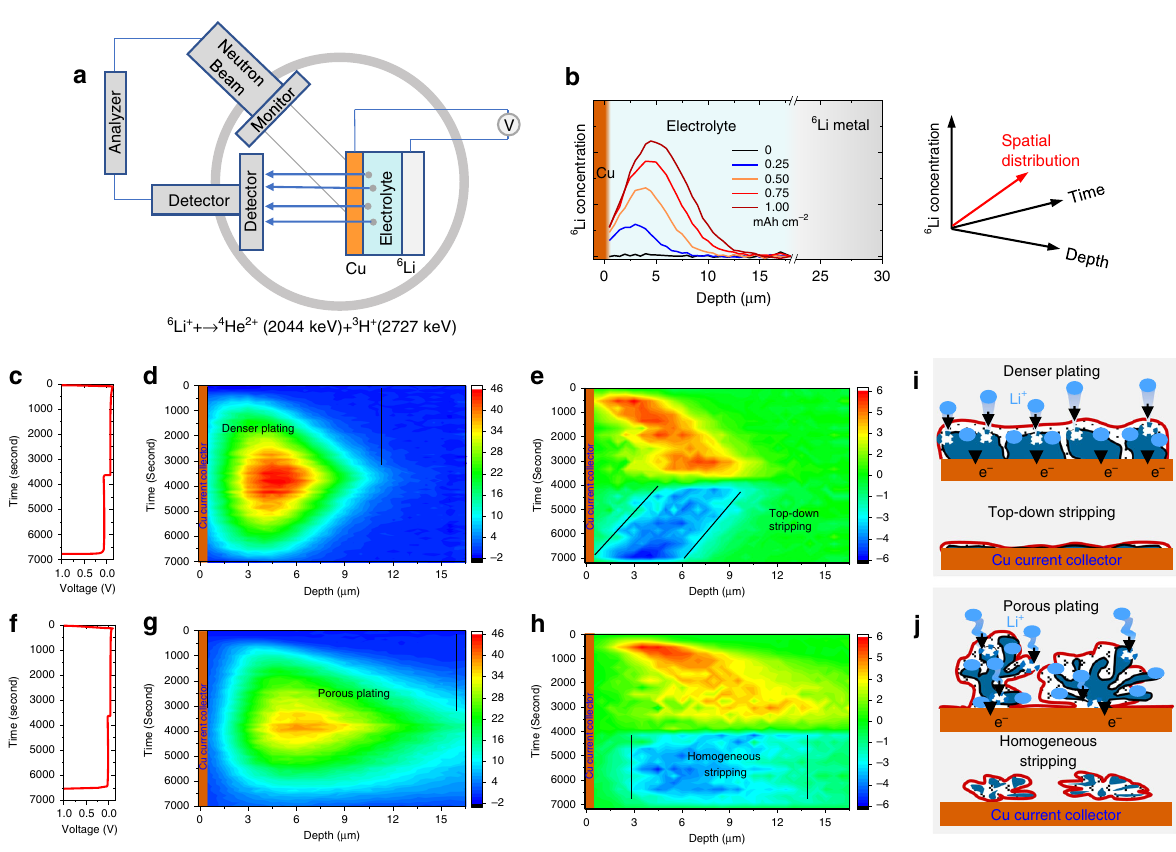
Fig. 5 Li + plating/stripping by operando neutron depth pro fi le. a The schematic operando neutron depth pro fi le (NDP) setup. b Depth pro fi les during Li